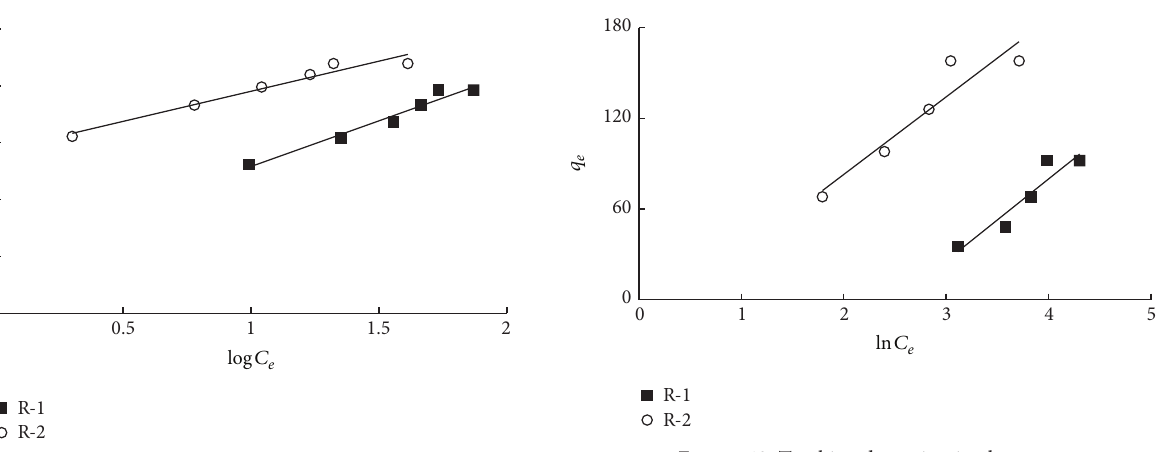
Figure 9: Freundlich adsorption isotherms.